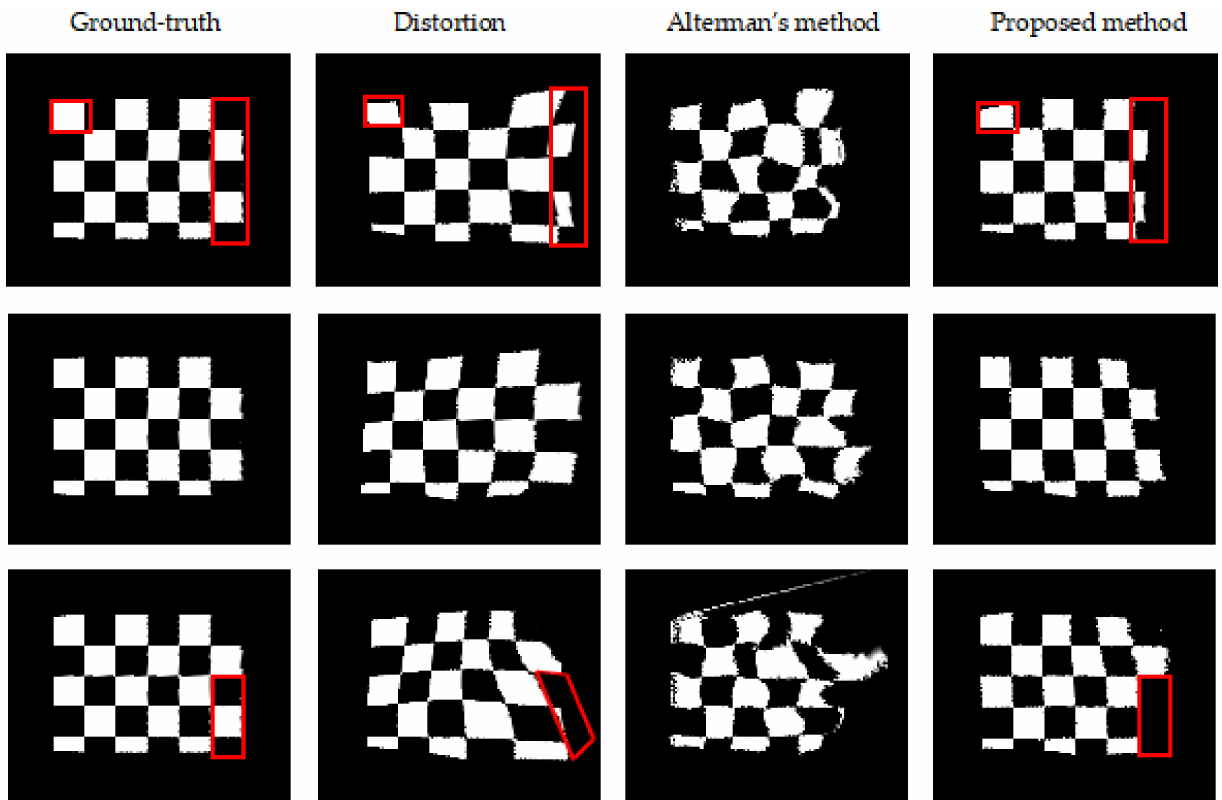
Figure 16. Results of images recovered by the estimated wavy WAI with the two methods